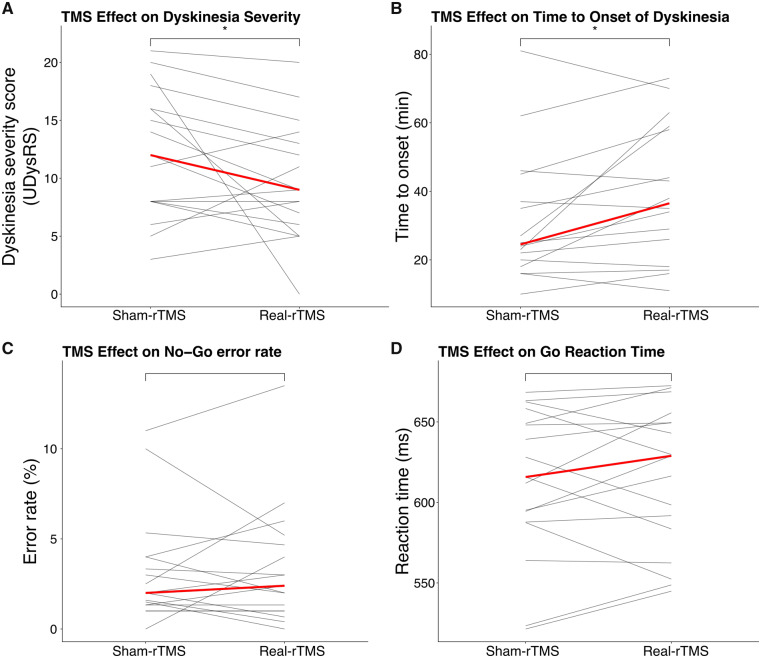

Inhibitory 1-Hz rTMS of preSMA improves clinical outcome variables in a dose-dependent manner. (A) TMS effect on dyskinesia severity (UDysRS). (B) TMS effect on the time from levodopa intake to the onset of dyskinesia. (C) Error rate (no-go commission errors). (D) Reaction times for go trials. *P < 0.05 (one-sided Wilcoxon signed-rank test). Red line represents the median.